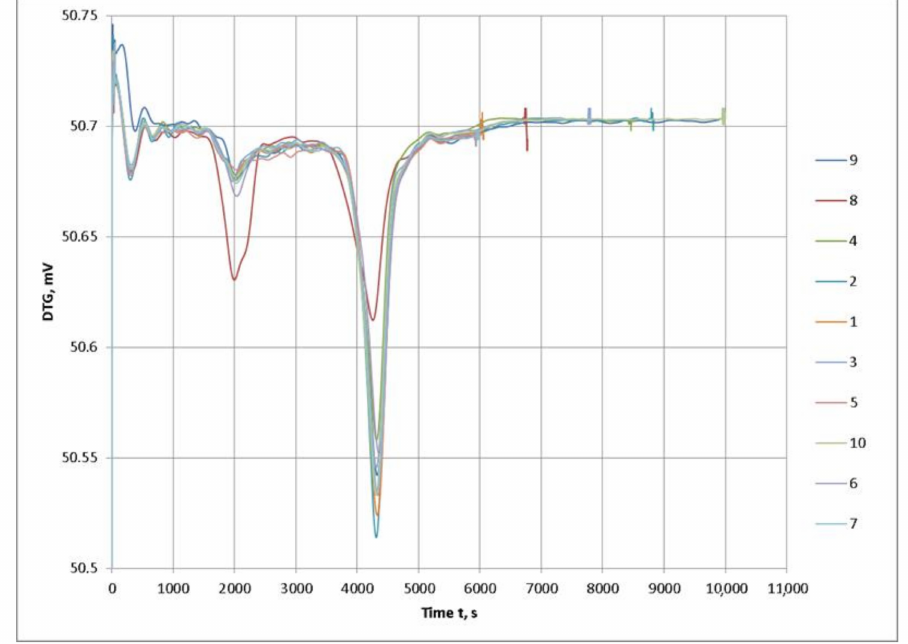
Figure 5. DTG thermograms of the examined PFA samples of the di ff erent